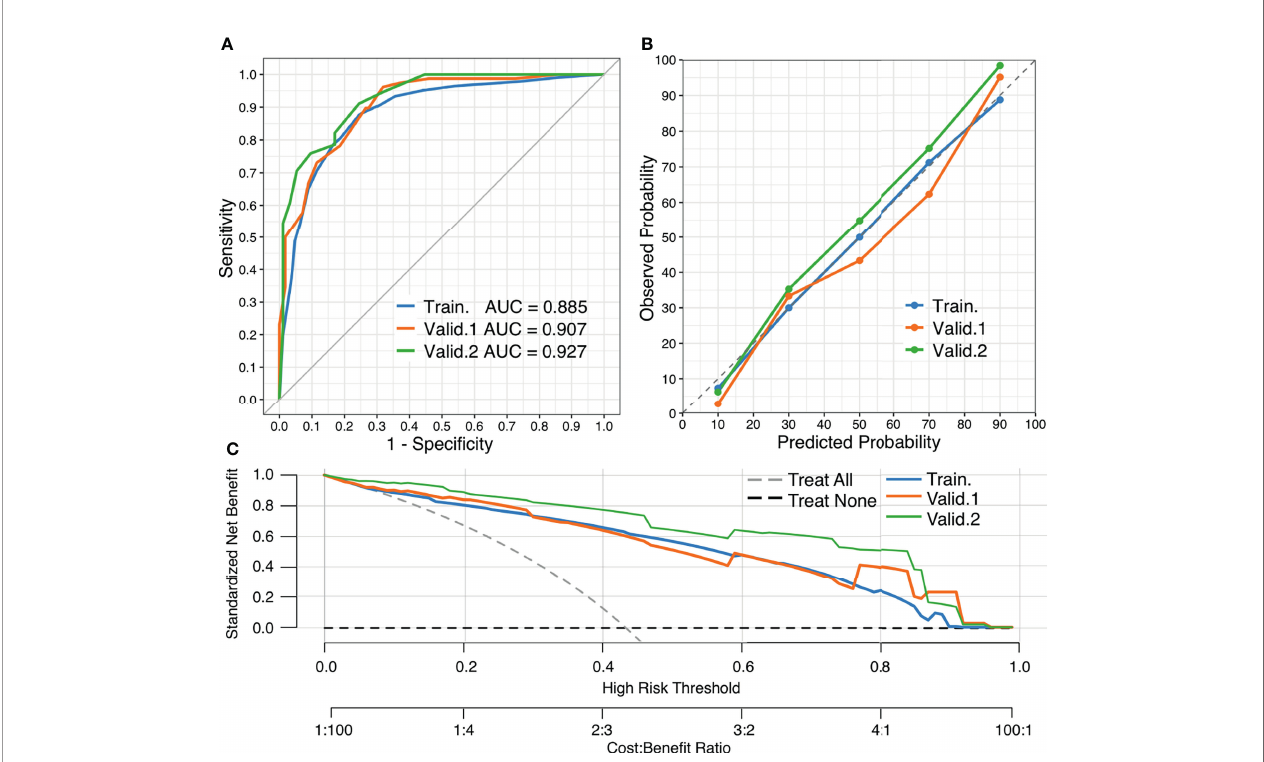
FIGURE 7 | Performance of the nomogram. (A) ROC curves of the nomogram in the training and external validation cohorts, respectively. (B) Calibration curves of the nomogram, which depict calibration of the nomogram in terms of agreement between the predicted risk of breast malignancy and observed outcomes. The diagonal dotted line denotes a perfect prediction, the closer the calibration curve fi t is to the diagonal line, the better the predictive accuracy of the nomogram. (C) DCA curves of the nomogram. The gray and black dotted lines represent the hypothesis that all patients had a diagnosis of breast malignancy ( “ treat all ” ) and that no patients had a diagnosis of breast malignancy ( “ treat none ” ), respectively. X-axis indicates the threshold probability for pathological outcomes while the Y-axis indicates the standardized net bene fi t for a given threshold